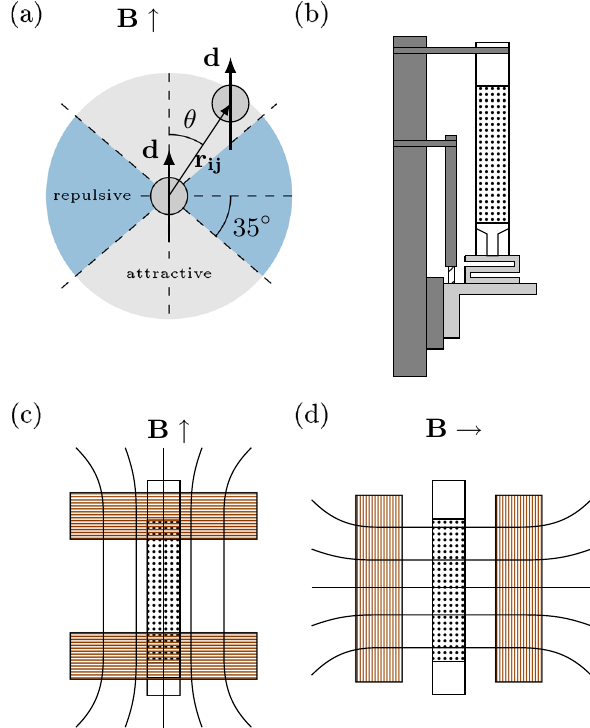
Fig. 1 Experimental setup. a Anisotropic magnetic dipolar interaction between two ferromagnetic particles subjected to the magnetic fi eld B . b Ferromagnetic particles fi ll a cylindrical tube and rest on a piston fi xed to a force sensor. This piston can be displaced vertically thanks to a motorized translation stage. c , d The column is placed between two magnetic coils mounted in a Helmoltz vertical or horizontal con fi guration to create a uniform magnetic fi